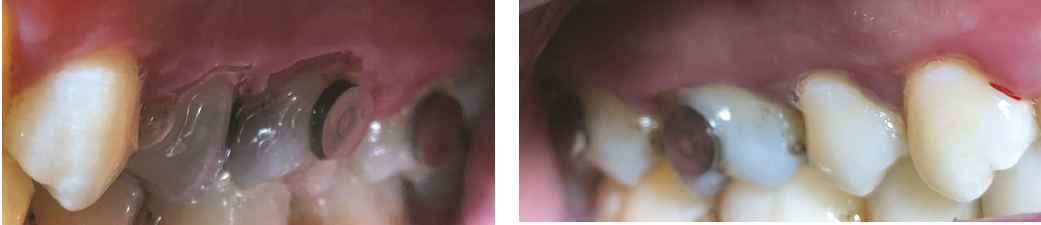
Figure 2: Titanium alloy discs attached to the buccal surfaces of maxillary molars.